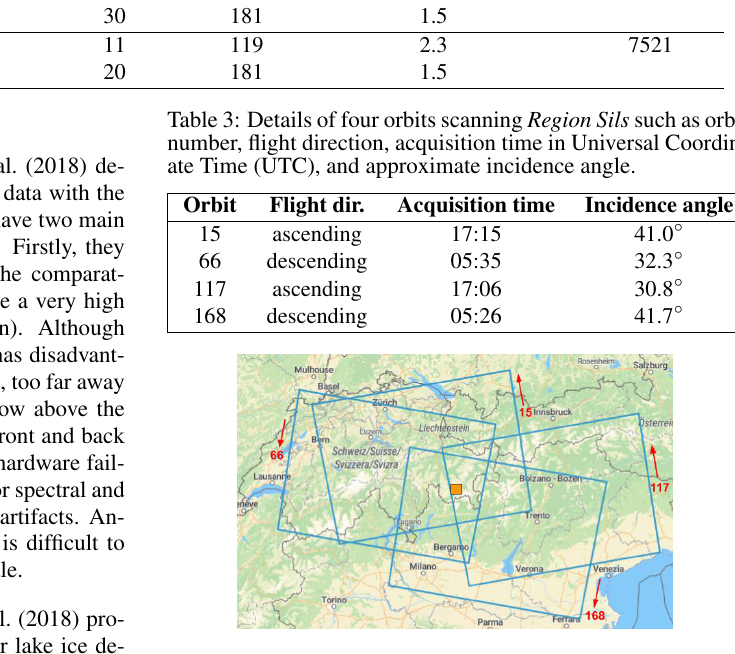
Figure 2: The four Sentinel-1 orbits ( 15 , 66 , 17 , 168 ) with the corresponding directions ( ascending or descending ) which cov- ers the Region Sils (shown as orange filled rectangle).